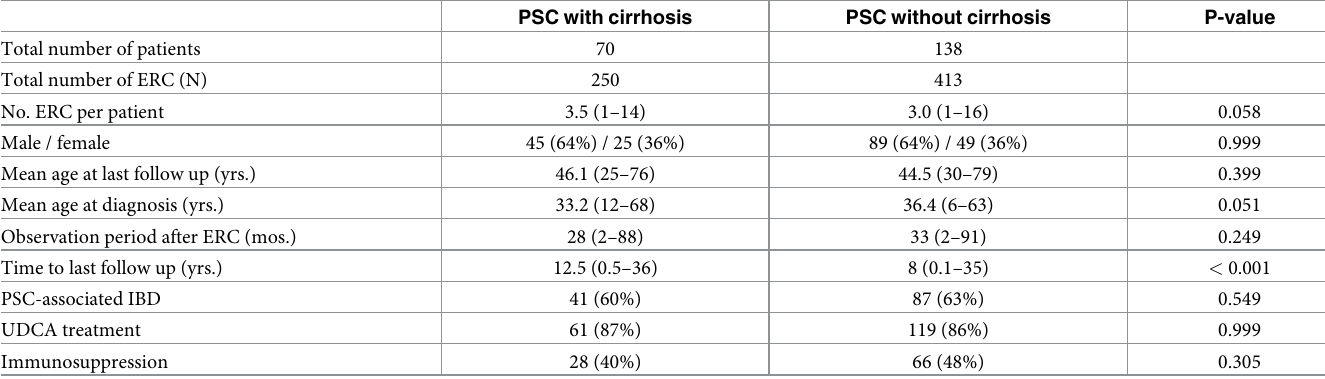
Table 1. Patient demographics.